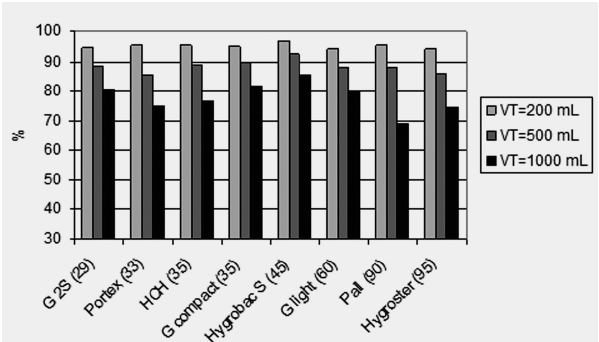
Figure 2 - Effect of tidal volume (200, 500 and 1000 mL) in the context of %RAH. The dead-space volume for each HME is shown in parentheses and the HME units are listed in order of increasing dead-space volume. Overall, the HME models differed slightly in terms of their ability to maintain absolute humidity levels, except when a high tidal volume was delivered. There was an inverse relationship between the efficiency of humidification and tidal volume. Hygrobac S was the HME model with the greatest